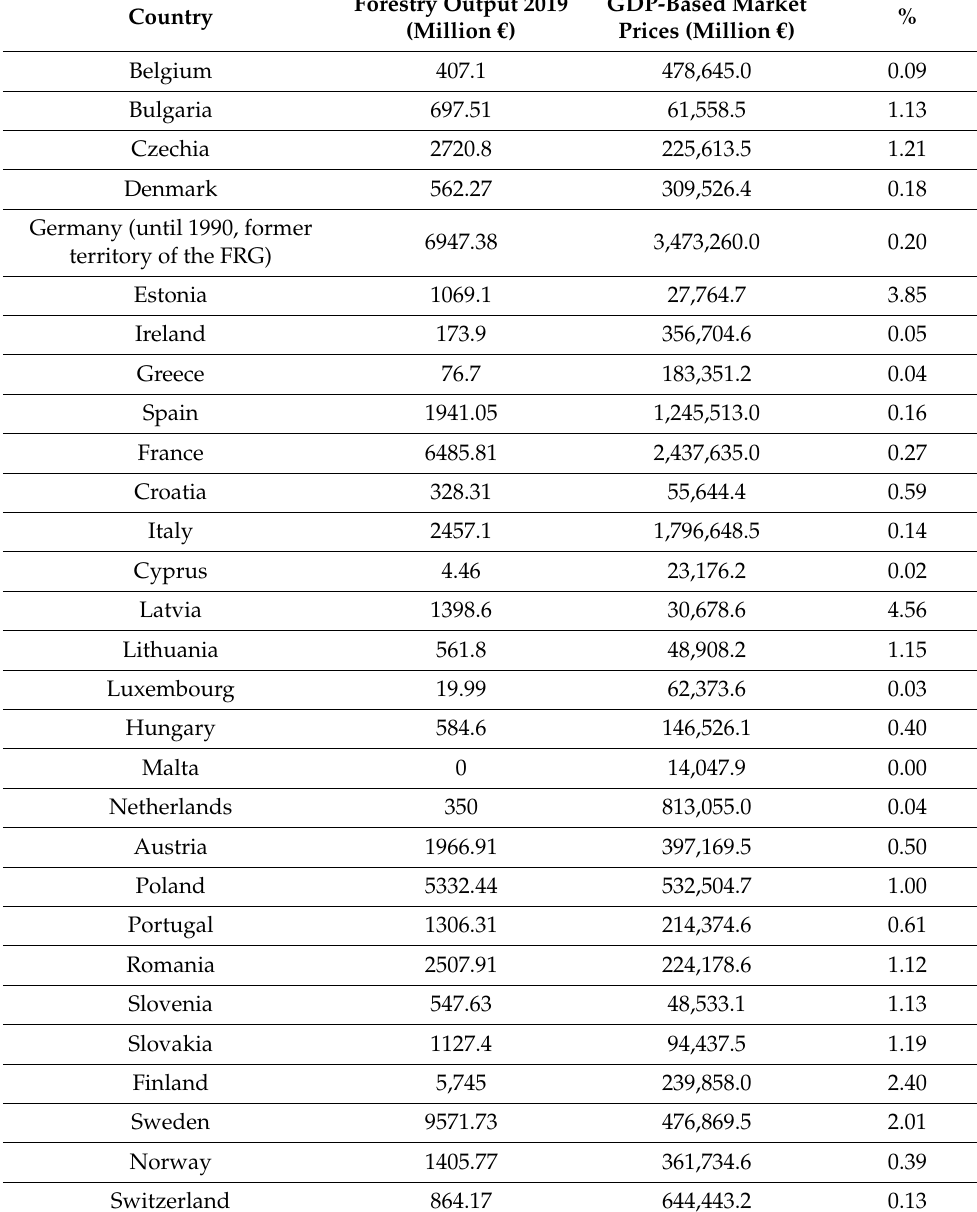
Table 1. Output of forestry and GDP in the year 2019 for selected European countries. Forestry Output Country